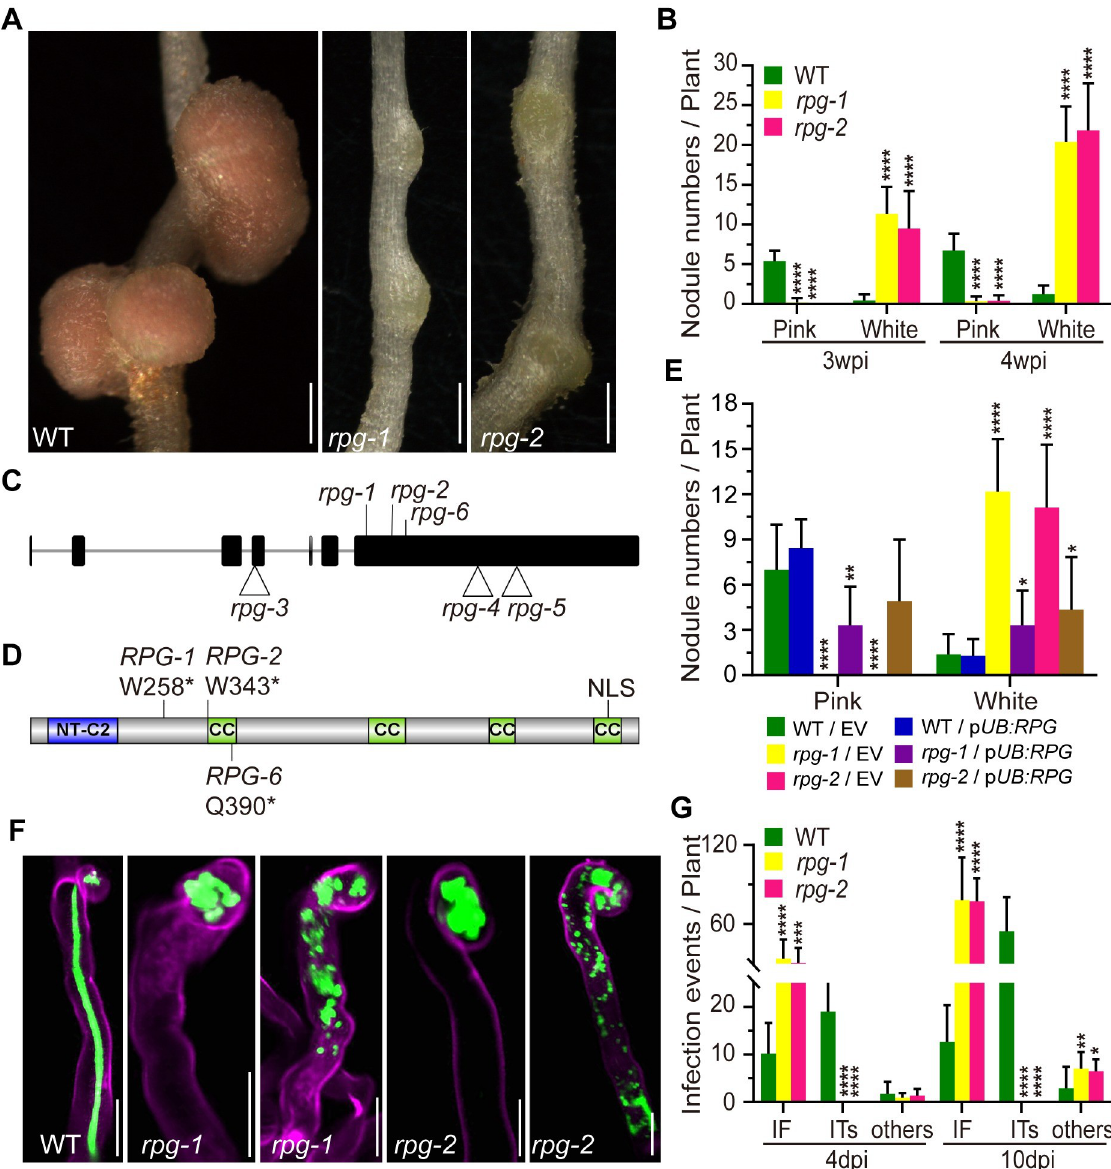
Fig 1. Phenotype and genotype of rpg-1 and rpg-2 mutants. (A-B) Nodule phenotype and the nodule numbers of wild type (WT) and rpg mutants two weeks after inoculation. The total number of nodules per plant was scored at three and four weeks after inoculation with M . loti R7A LacZ (n > 10). (C) The gene structure of RPG , showing seven exons and six introns. The position of three EMS mutations, rpg-1 (SL5706-3), rpg-2 (SL454-2) and rpg-6 (SL0181), and three LORE1 insertion mutations, rpg-3 , rpg-4 , and rpg-5 are shown. (D) Outline of RPG protein structure, indicating the predicted NT-C2 domain, four coiled-coil (CC) domains, and a predicted nuclear localization signal (NLS). The locations of translation stops ( � ) in RPG-1 , RPG-2 and RPG-6 are indicated. Images (C and D) were created using IBS1.0.3 software. (E) The nodule numbers of WT, rpg-1 and rpg-2 mutant plants in roots transformed with the vector control (EV) or p UB : RPG and scored three weeks after inoculation with M . loti R7A/LacZ (n > 7). (F) Infection phenotypes of WT, rpg-1 and rpg-2 mutants were visualized by fluorescence microscopy of roots inoculated with M . loti R7A/GFP. Shown are a normal elongating IT in WT, and infection foci (IF) and abnormal ITs observed in rpg-1 and rpg-2 mutants. Roots were scored seven days after inoculation and were counterstained with propidium iodide. Green fluorescence shows rhizobia and magenta fluorescence shows root hair stained with propidium iodide. (G) Number of infection events in WT plants and rpg mutants. The total number of infection events per plant was scored 4 and 10 days after inoculation with M . loti R7A/LacZ. IF, infection foci; ITs, infection threads; Others correspond to abnormal ITs in root hairs as illustrated in panel F (n > 9). Asterisks indicate significant differences between WT and rpg mutants at the indicated time points (B and G), or between the EV control and experimental group (E) (Student’s t -test). Scale bars: 1 mm (A); 20 μ m (F).